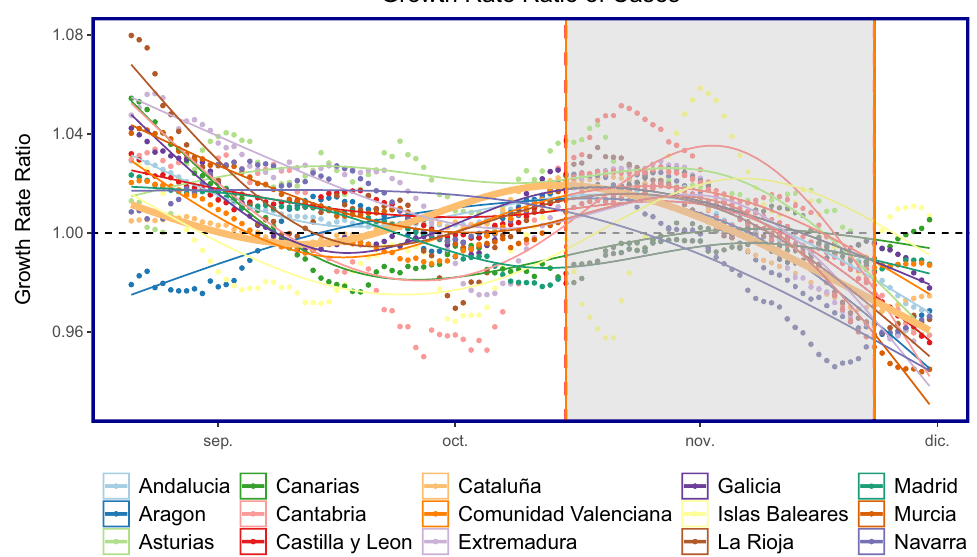
Figure 8. Growth rate ratio (GR) of cases: all autonomous communities are shown as points with Cataluña shown as the thicker line plot for ease of composition. The shaded area corresponds to when the policy of closing bars and restaurants in Cataluña was implemented. On the x-axis, dic refers to Diciembre (December).